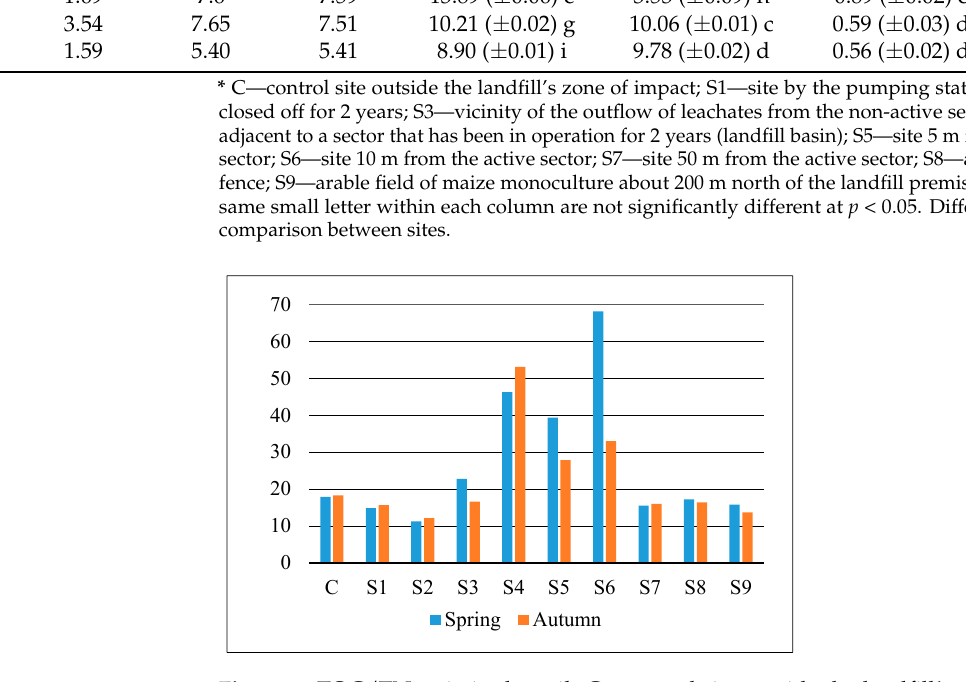
Figure 3. TOC/TN ratio in the soil. C—control site outside the landfill’s zone of impact; S1—site by the pumping station; S2—non-active sector closed off for 2 years; S3—vicinity of the outflow of leachates from the non-active sector; S4—landfill premises adjacent to a sector that has been in operation for 2 years (landfill basin); S5—site 5 m from the basin of the active sector; S6—site 10 m from the active sector; S7—site 50 m from the active sector; S8—area adjacent to the landfill fence; S9—arable field of maize monoculture about 200 m north of the landfill